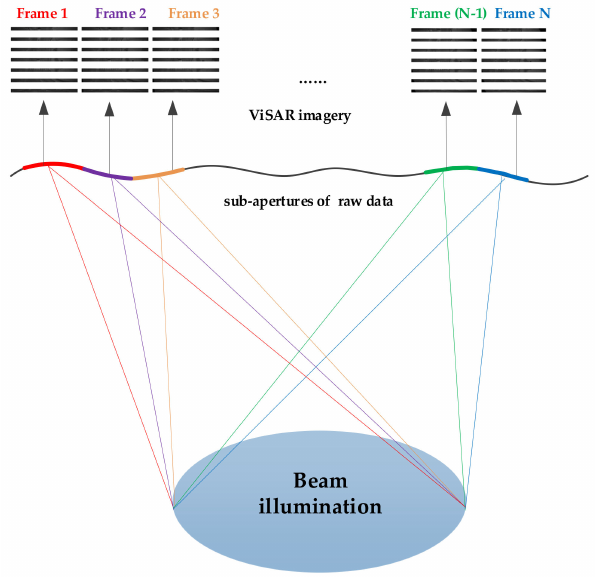
Figure 1. Geometry of